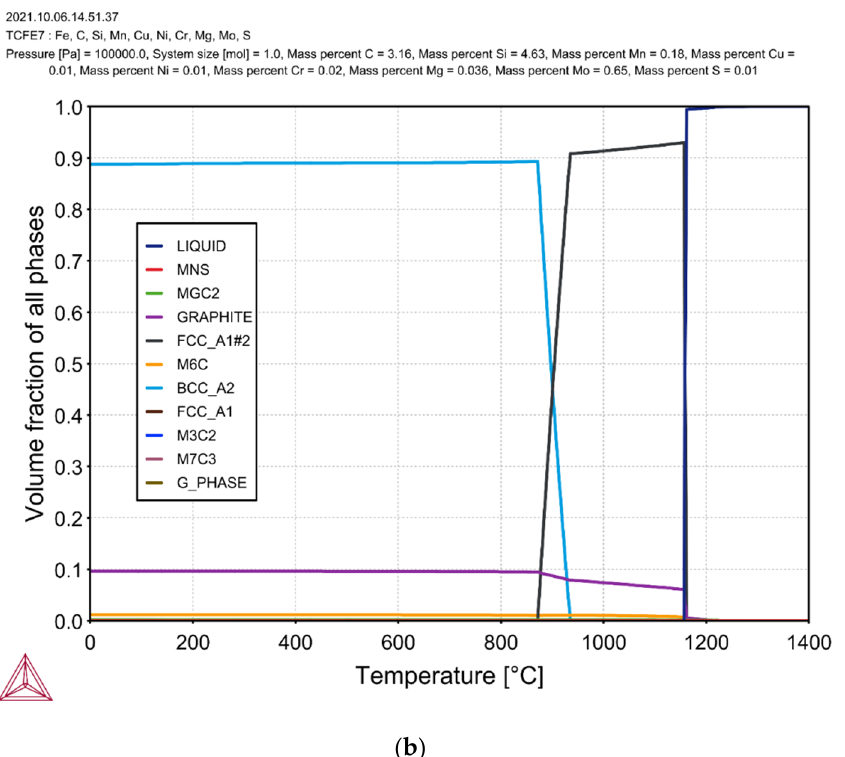
Figure 2. ( a ) Thermo-Calc phase diagram of Si–Mo ductile iron; ( b ) volume fraction of all phases formed.